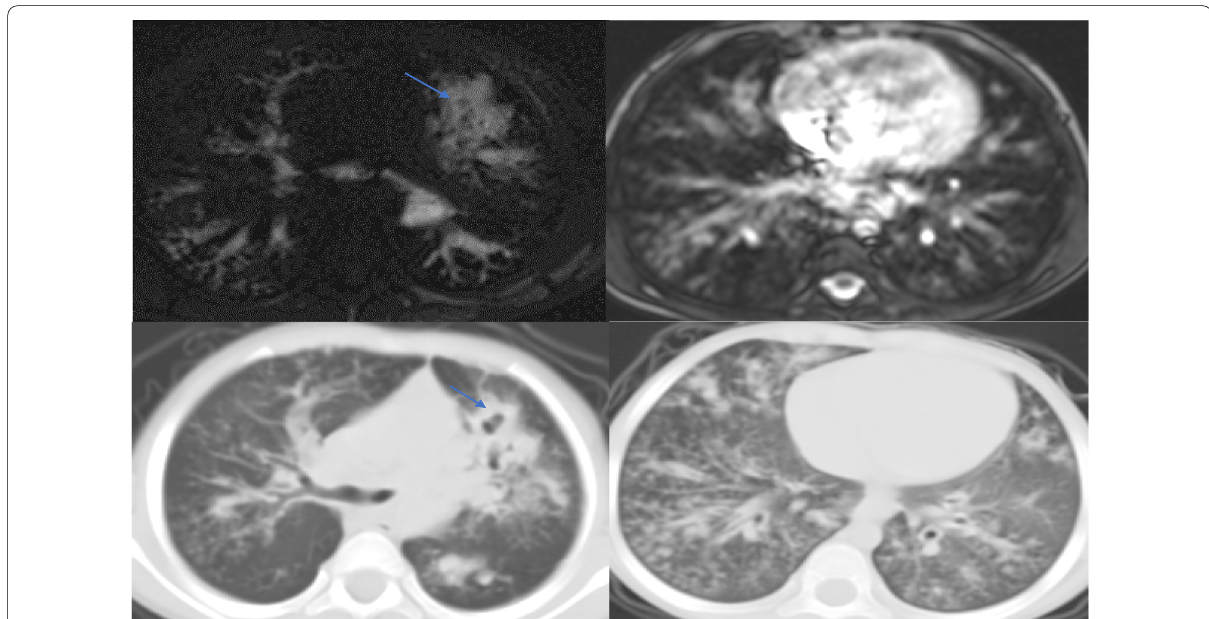
Fig. 1 A 5-year-old male, known with cystic fibrosis, MRI T2 TRUFI, and comparable HRCT cuts, shows bilateral score 1 bronchiectasis, score 2 bronchial wall thickening, score 3 generation of bronchi, diffuse centrilobular nodules and tree in bud appearance, and mucoid impaction (arrows), CT score 21, MRI score